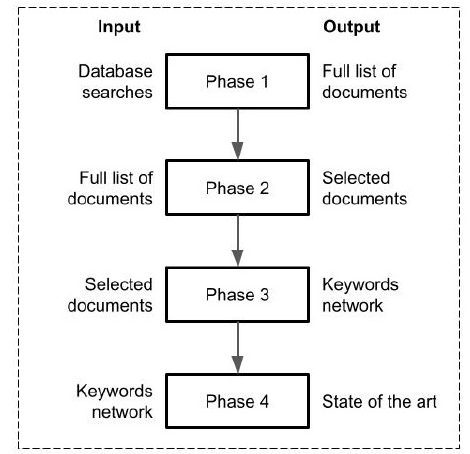
Figure 2. Proposed four-phase method of